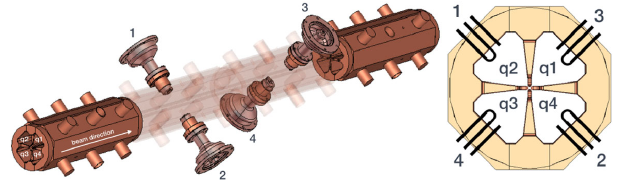
FIG. 19. The picture shows a 3D drawing of the RFQ with tuners, pumping ports, and power couplers (left) and a cross section of the RFQ indicating the numbering of the quadrants and the power couplers.